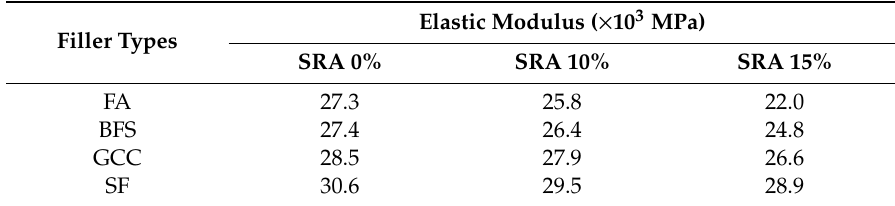
Table 12. Elastic moduli of UP concrete with SRA contents and filler types.